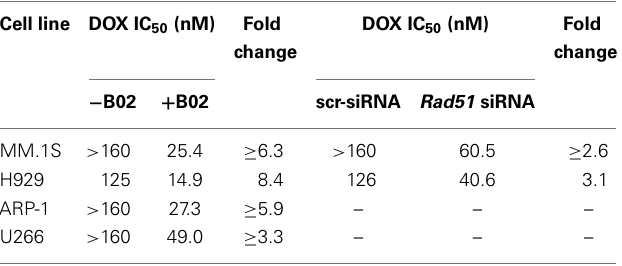
Table 1 | Pre-treatments targeting Rad51 sensitize myeloma cells to DOX .